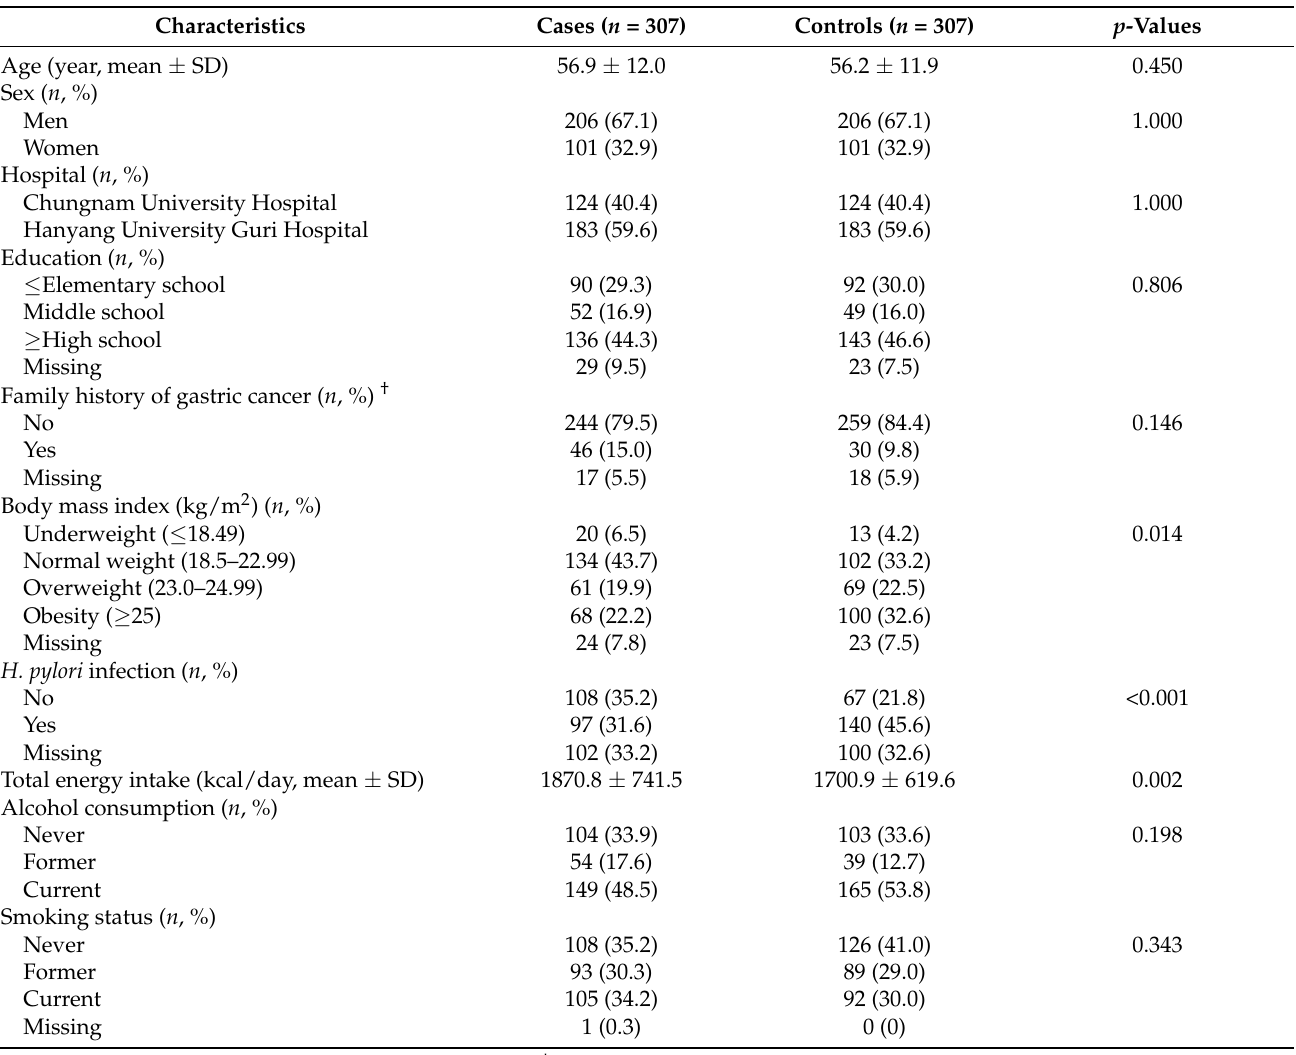
Table 1. Participant characteristics of gastric cancer cases and controls.